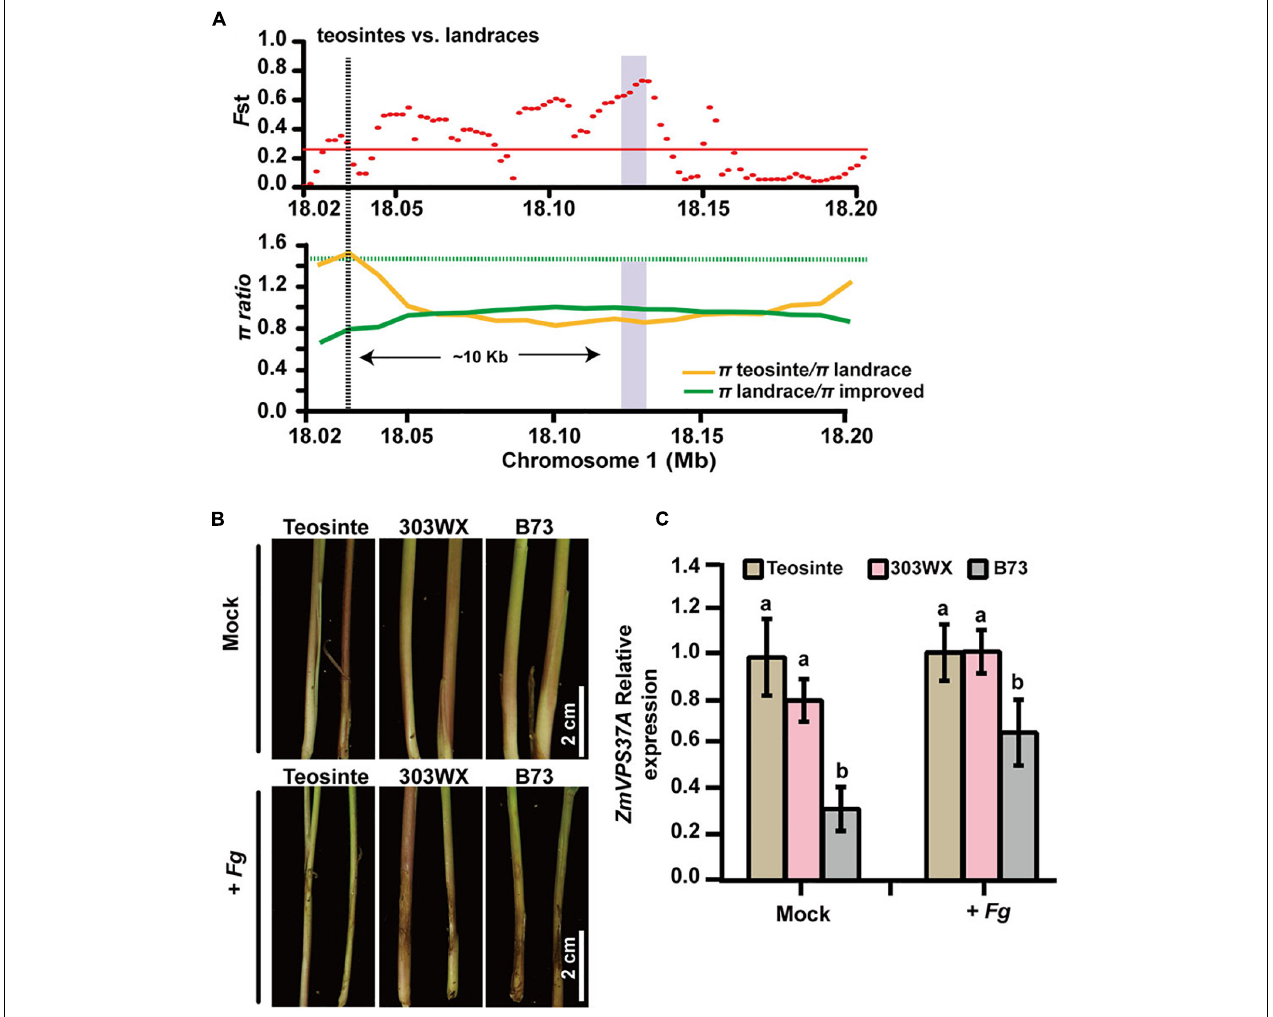
FIGURE 7 | ZmVPS37A is a domestication gene involved in pathogen defense. (A) Fst (upper) and π (lower) values in teosinte and landrace across the 0.18-Mb genomic region surrounding the ZmVPS37A gene, which is indicated by the purple bar. (B) The stalk phenotypes of teosinte, 303WX, and B73 seedlings 7 days after inoculation by Fusarium graminearum PH-1. (C) Gene expression analysis of ZmVPS37A responding to F. graminearum PH-1 48 h after infection. Values are mean ± s.d. Significant differences are shown by different letters ( p <